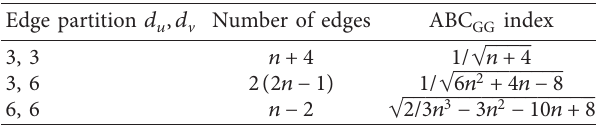
Table 10: Edge partition of chain silicate network of n order. Table 11: Edge partition of chain silicate network of even